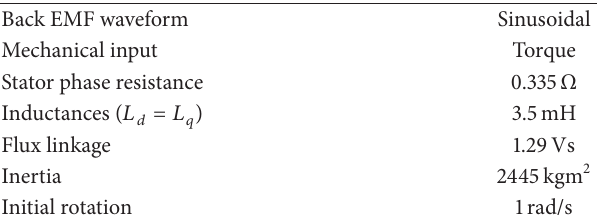
Table 2: Permanent magnet synchronous machine in Simulink. Back EMF waveform Sinusoidal Mechanical